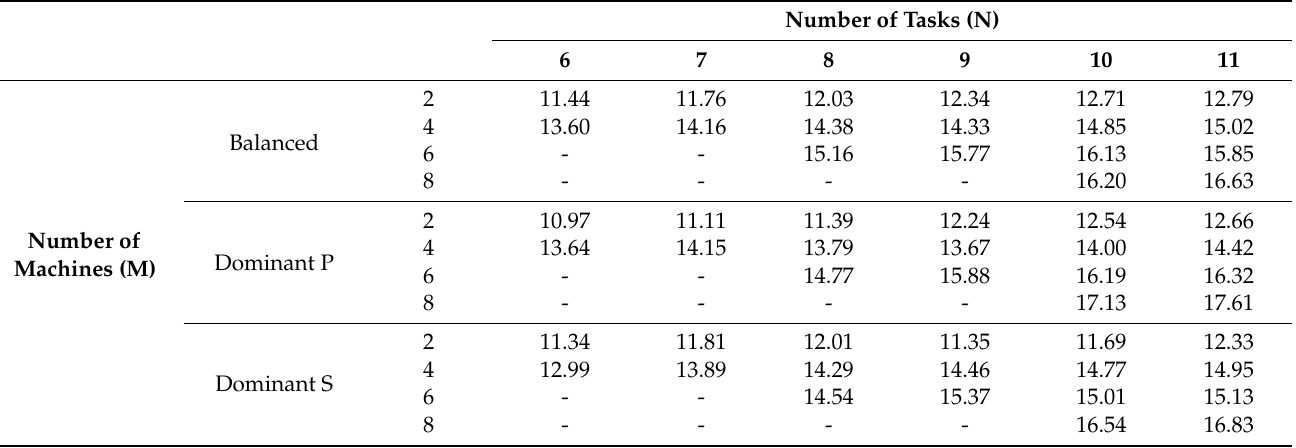
Table 4. Average GA execution time for Balanced, Dominant P, and Dominant S for small